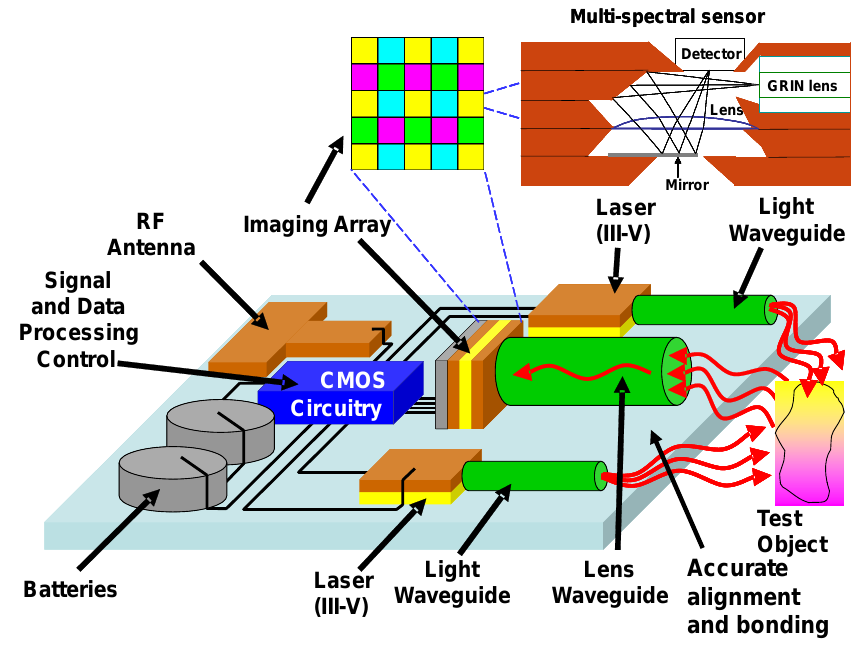
Figure 17. Schematic diagram of an emerging integrated micro-optical system for health